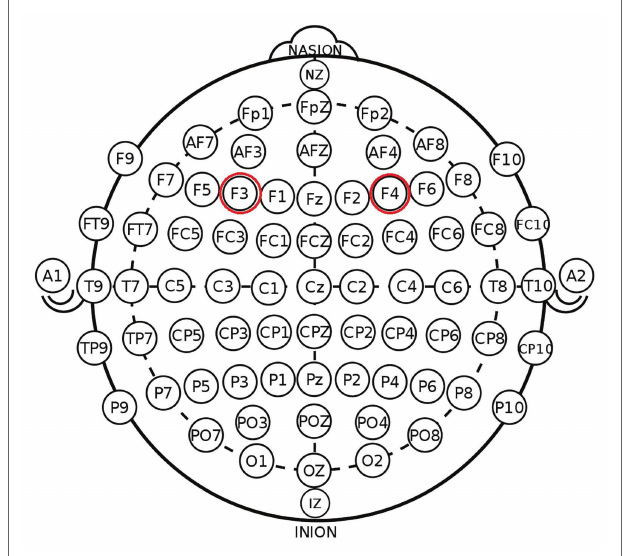
FIGURE 1 | Schematic and locations of electrode